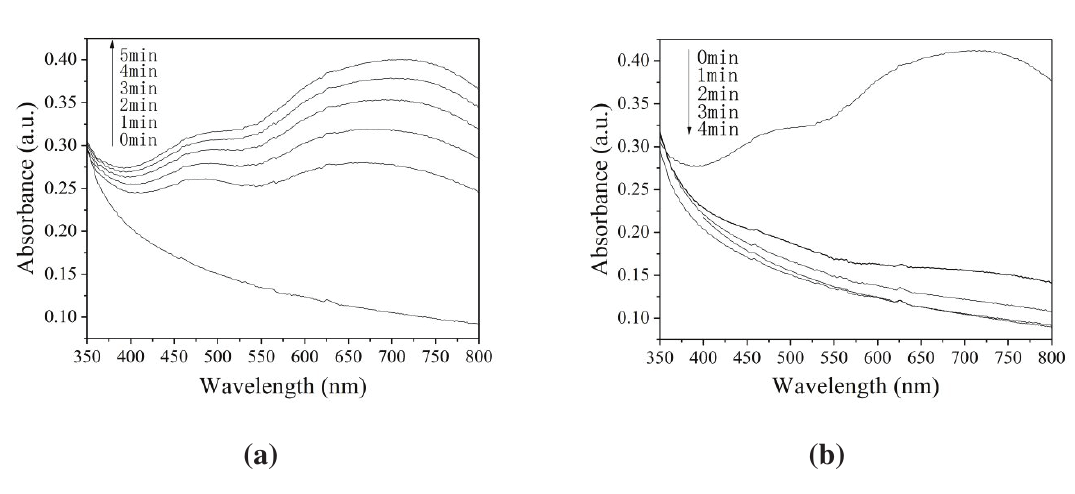
Figure 6: UV-vis spectra of PWA/P (1VPco1MA) with different times of irradiation time (a) and UV-vis spectra of PWA/P (1VPco1MA) with different times of bleaching time (b).